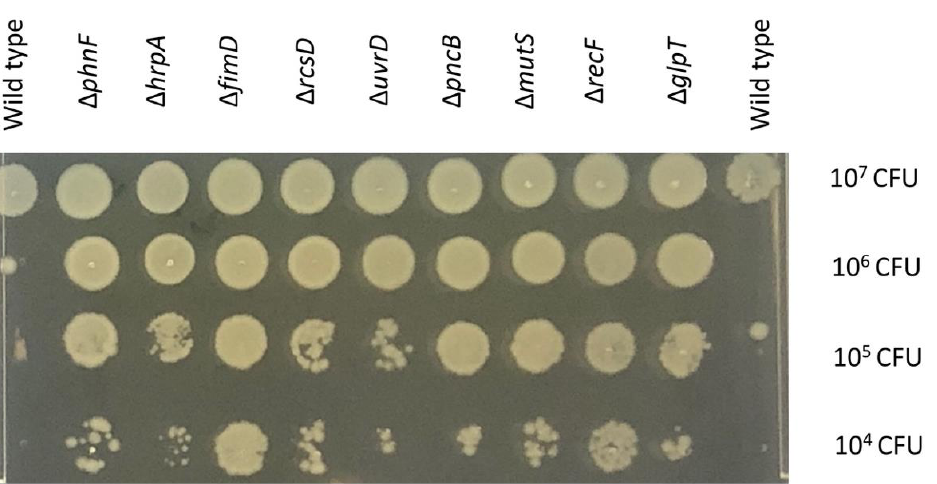
Figure 2. Validation of the contributions of defined mutants to colistin sensitivity. Mutants and the wild type were serially diluted (10 7 , 10 6 , 10 5 , 10 4 colony-forming units from top row down) onto an MH agar plate containing 0.5 μ g/mL of colistin and incubated overnight at 37 °C.